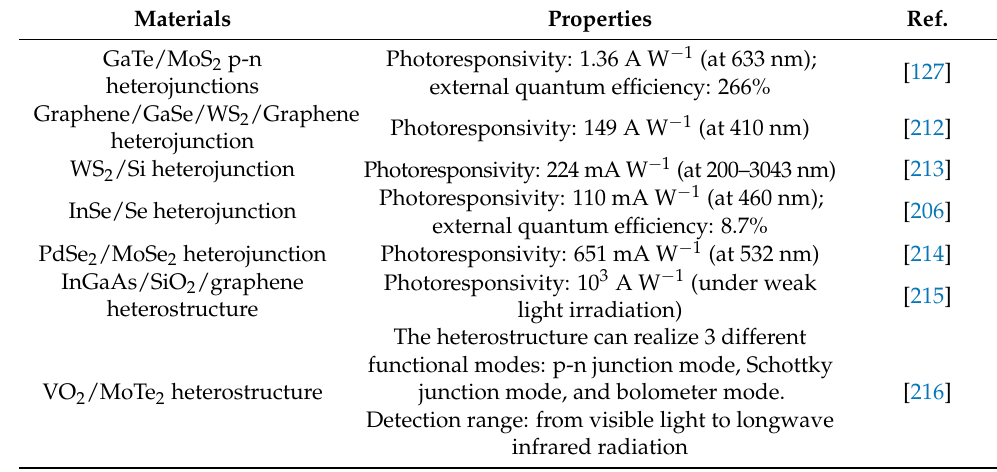
[127] [213] [206] [215]